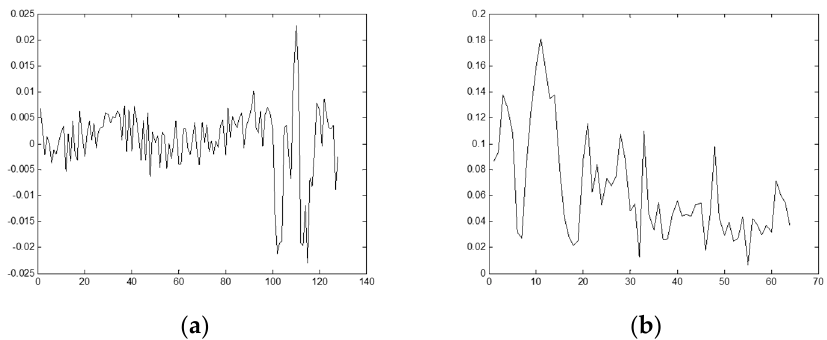
Figure 19. Walking signal recognized as picking signal. ( a ) Time domain; ( b ) Frequency domain; Table 3. The identification rate of walking signals.